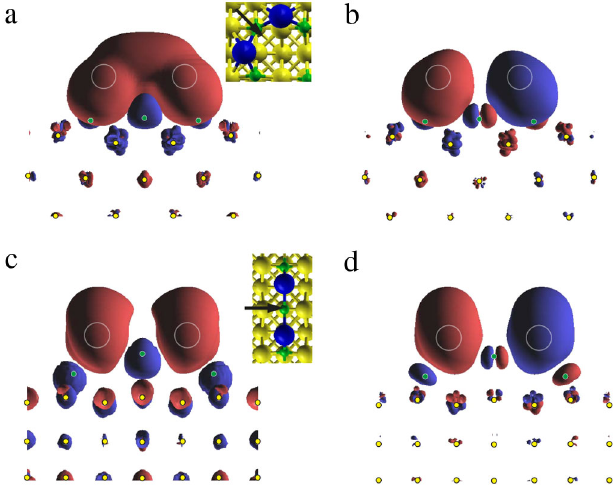
FIG. 4. Calculated spin-density isosurfaces of diagonal and linear Gd dimers on CuN in their ferromagnetic and antiferro- magnetic configurations. (a),(b) The side views of the ferromag- netic and antiferromagnetic diagonal dimers. (c),(d) The side views of the ferromagnetic and antiferromagnetic linear dimers. Red stands for positive magnetization, and blue for negative. The open white circles indicate the muffin-tin spheres of the Gd atoms. The black arrow in the stickball inset of each plot indicates the observation direction. The green and yellow solid circles denote the positions of N and Cu atoms, respectively. All spin densities are plotted at the magnitude of 0 : 001 e=a 3 0 , where a 0 is the Bohr